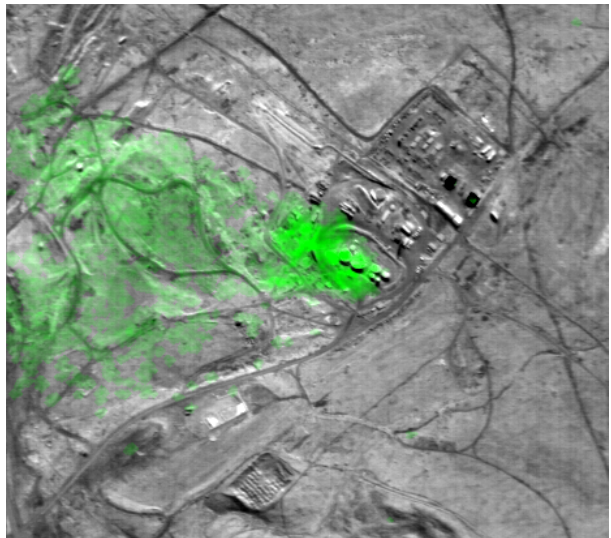
Figure 2. Flagged image; green indicates the HyTES clutter matched filter has detected methane in that